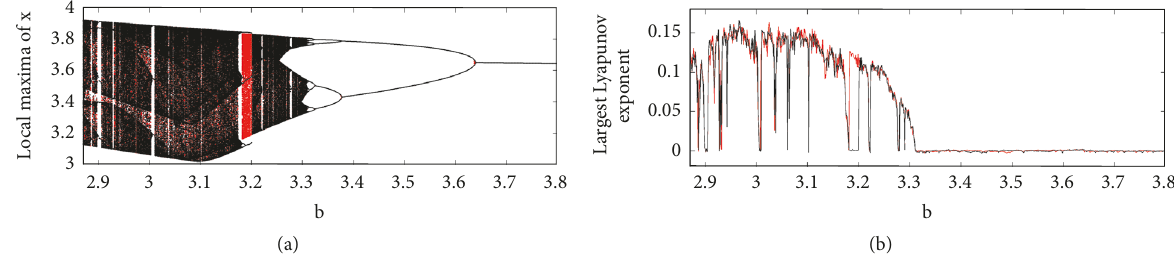
Figure 5: (Color online) The bifurcation diagrams depicting the local maxima of 𝑥(𝑡) (a) and the largest Lyapunov exponents (b) versus the parameter 𝑏 for 𝑎 = 3.3 . In the graph (a), two sets of data corresponding, respectively, to increasing (black dot) and decreasing (red dot) values of 𝑏 are superimposed. Largest Lyapunov exponents are obtained by scanning parameter 𝑏 upwards (black line) and downwards (red line).